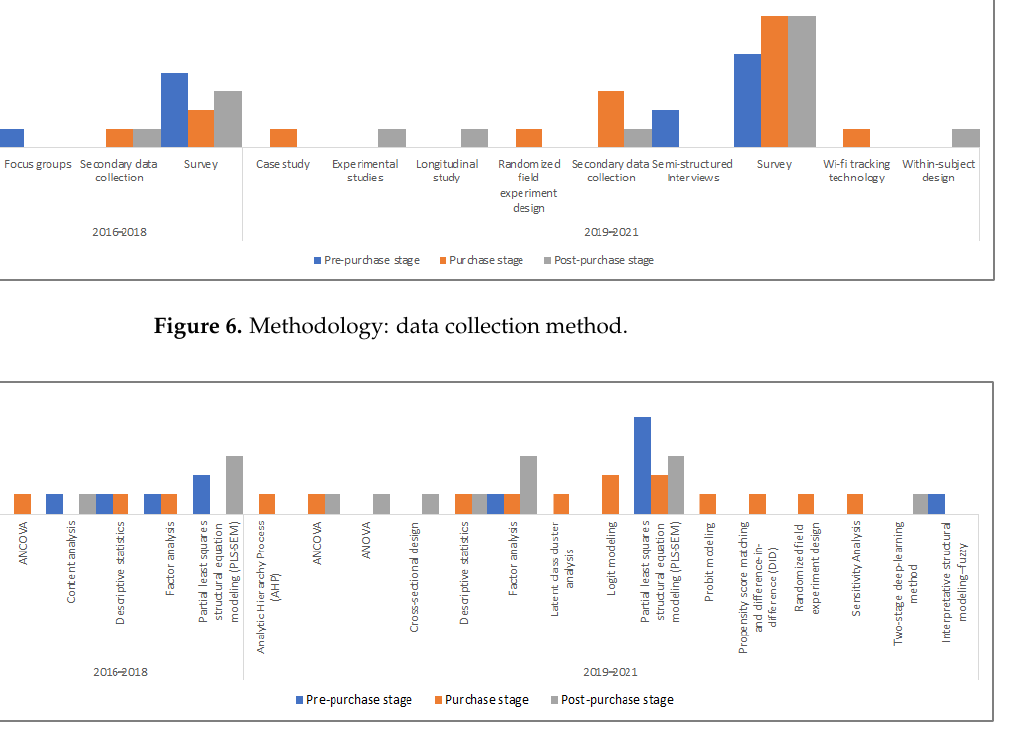
Figure 7. Methodology: data analysis method.